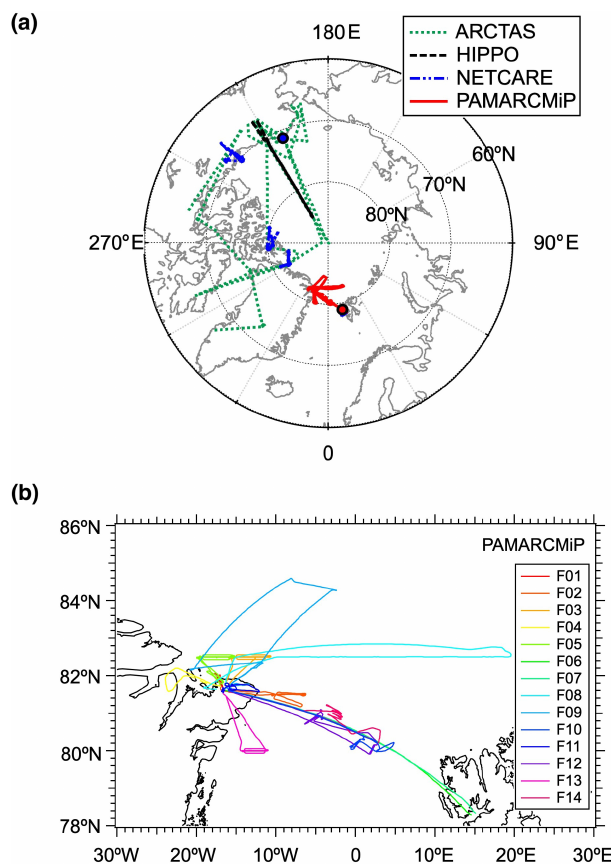
Figure 1. (a) Map of the flight tracks of the PAMARCMiP aircraft- based field experiment and the other three experiments made over the Arctic in spring. In this study, only data obtained at latitudes north of 66.5 ◦ N were used and only the flight tracks for them are shown. The locations of the high Arctic sites Ny-Ålesund in Sval- bard (78.9 ◦ N, 11.9 ◦ E) and Barrow in Alaska (71.3 ◦ N, 156.6 ◦ W) are indicated by the red and blue circles, respectively. (b) Map of the details of the flight tracks of the PAMARCMiP